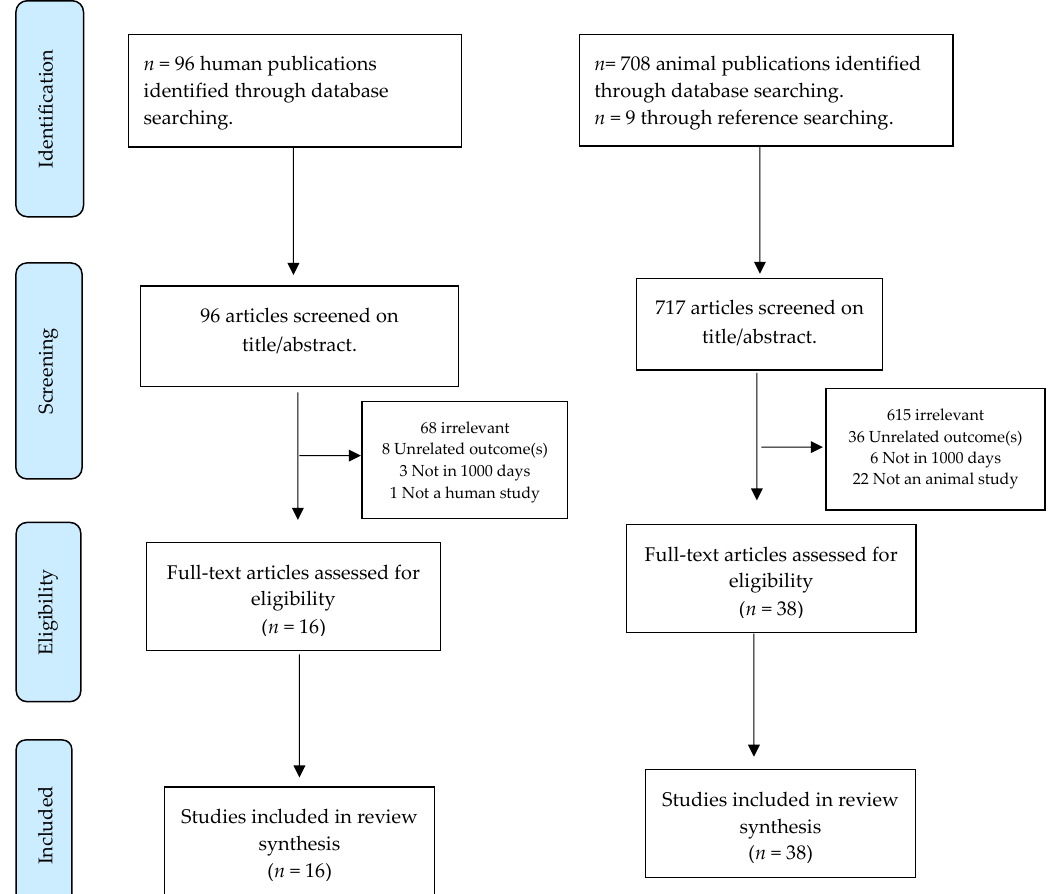
Figure 1: PRISMA algorithm used to identify studies